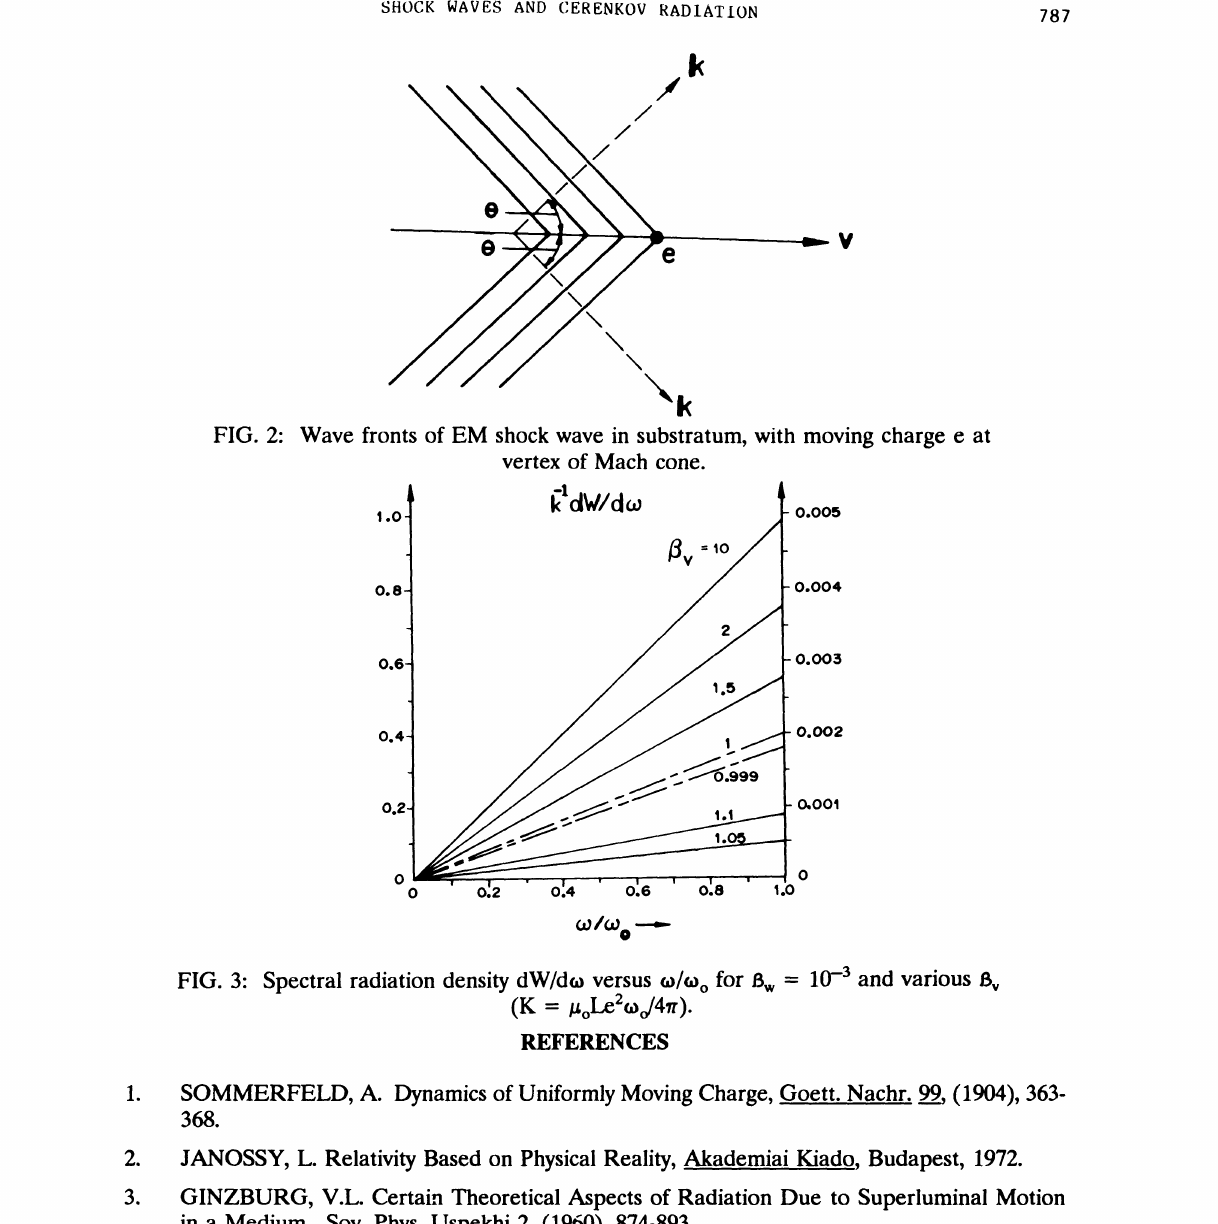
FIG. 3: Spectral radiation density dW/dto versus o/to for 8, 10 -3 and various (K